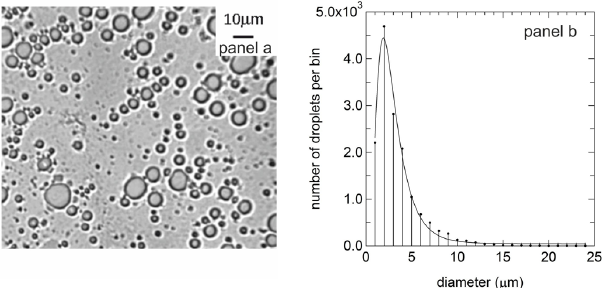
Fig. 1. (a) Optical microscope image of a typical emulsion. (b) Size distribution of the